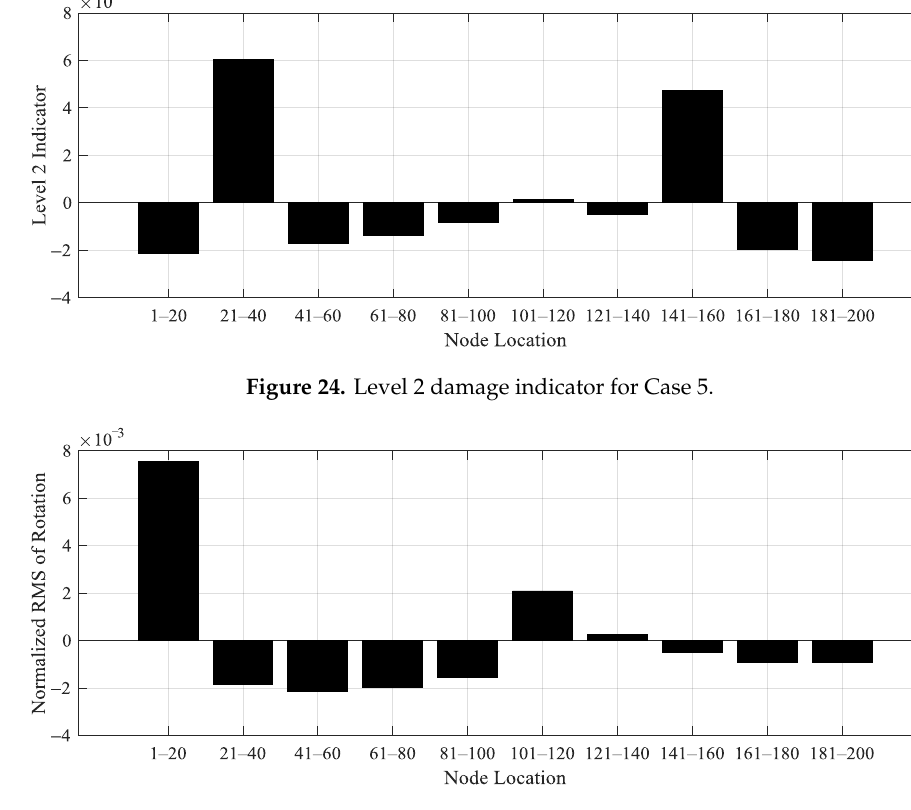
Figure 23. Level 2 damage indicator for Case 4.